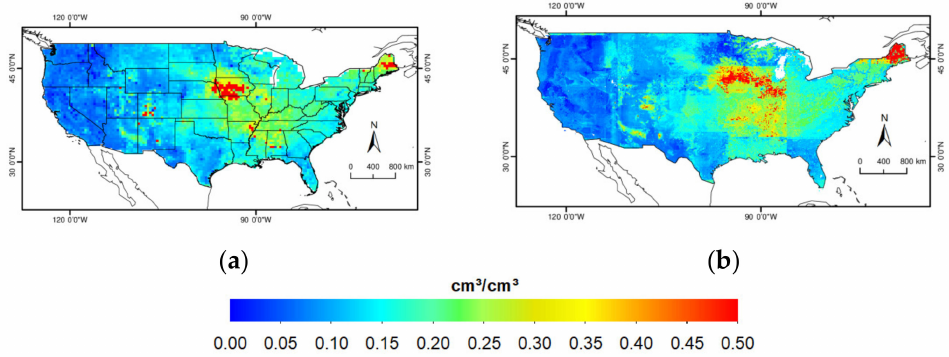
Figure 19. Comparison of SM maps with different resolutions; ( a ) 36 km and ( b ) 0.125 ◦